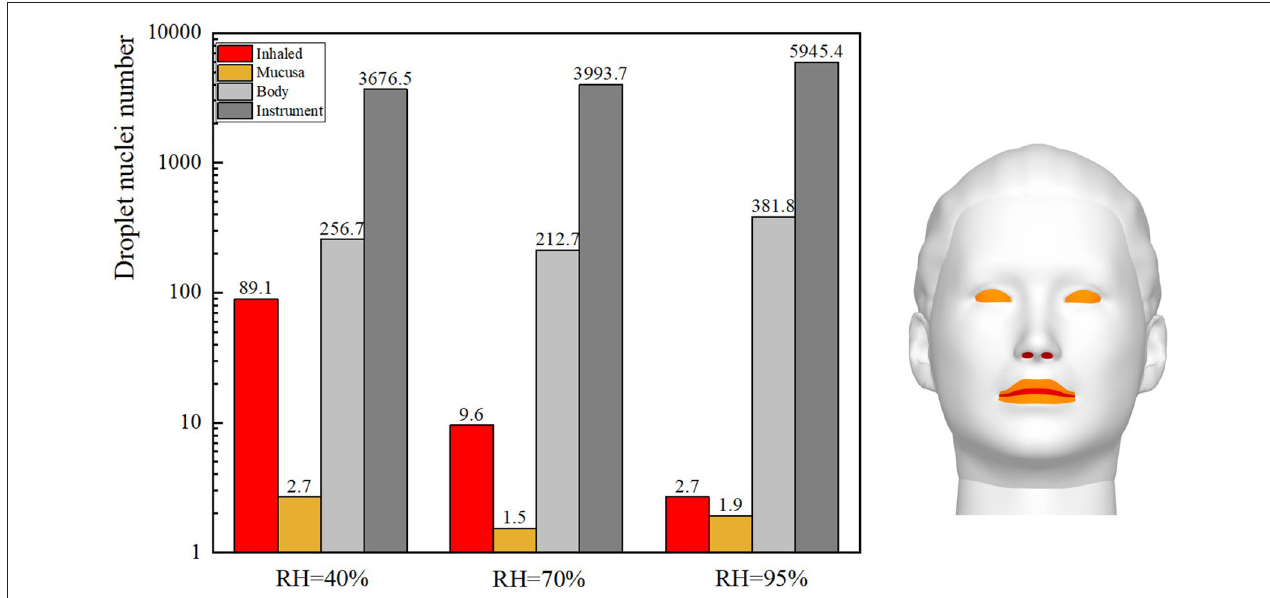
FIGURE 9 | Droplet exposure of ophthalmologists when the RH is 40, 70, or 95%.